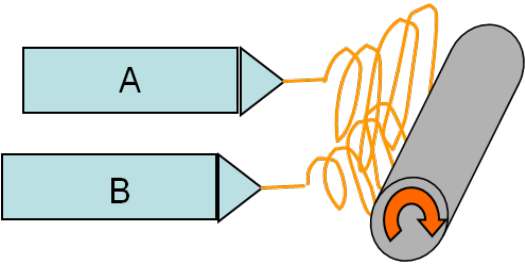
Figure 11. Schematic for horizontal paralleled electrospinning setup.